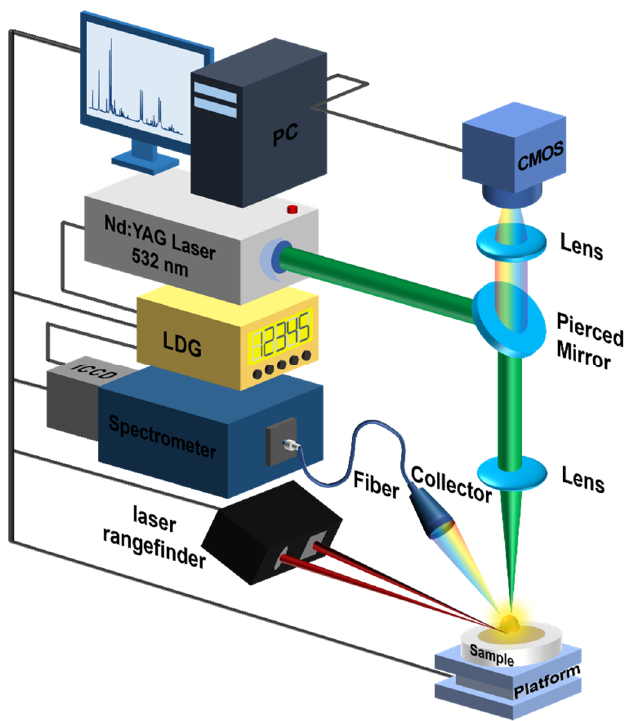
Figure 1. LIBS rice flour detection system device schematic.